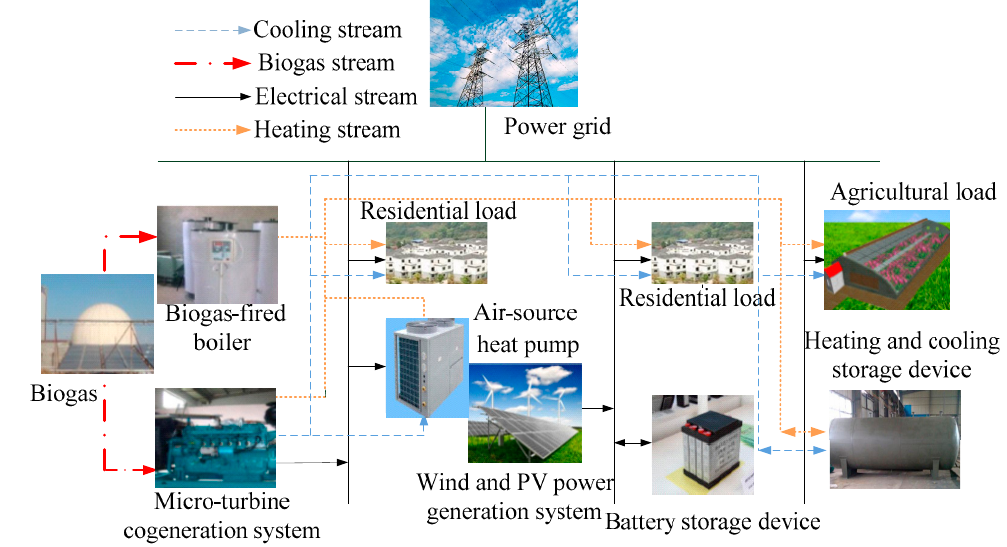
Figure 2. Energy-supply architecture of the micro-energy-grid.